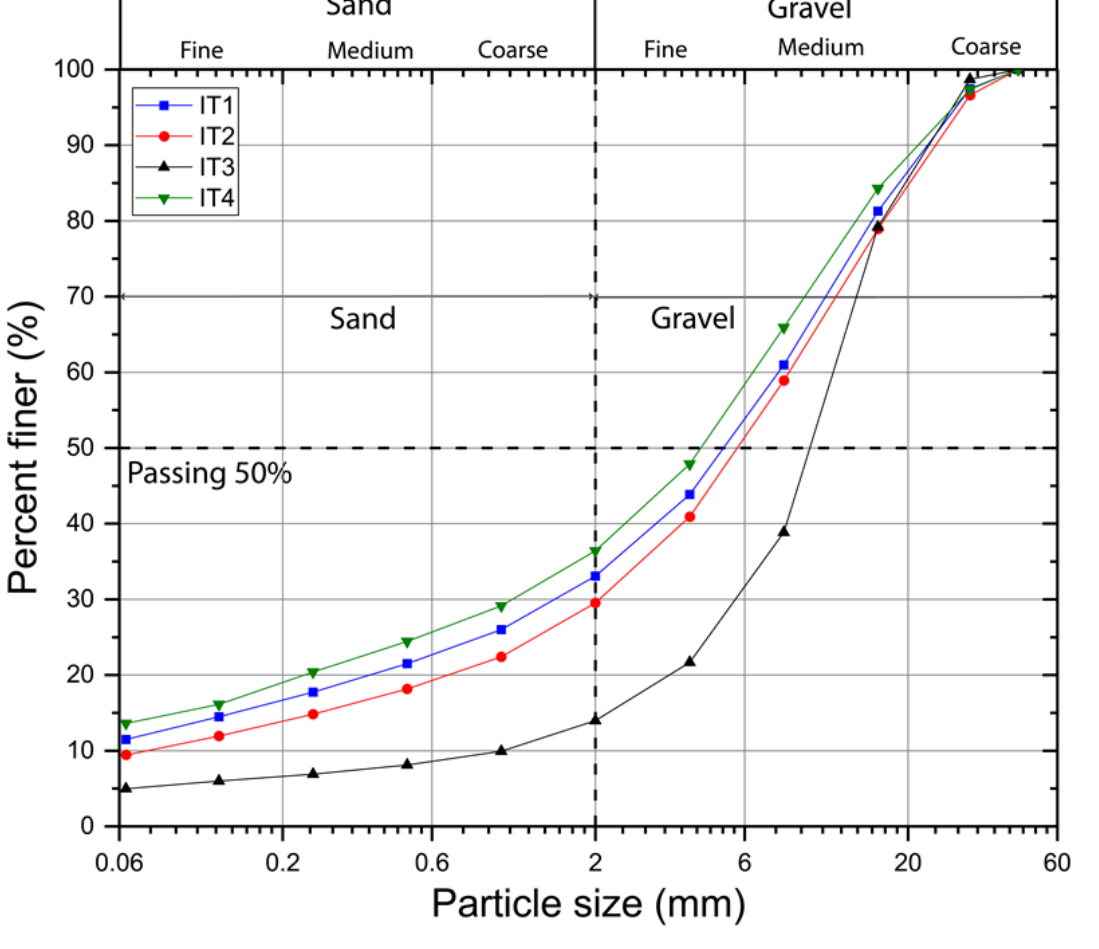
Figure 7. Grain size distribution (GSD) soil instrumented trenches IT1-IT4 after site-specific calibration process.